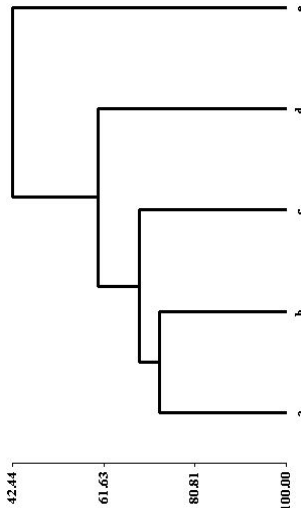
Fig. 3. UPGMA for 5 different cultivars of Catharanthus roseus (L.) G. Don. based on SI of three isozymes Polymorphism is essential in to use of isozymes as ge- netic marker. When considered the EST, PO and PPO isozymes polymorphism and their coding capacity of the molecules with different velocity, they are convenient for identification of genotypical differences. The topology of the plant based on the isozyme data in addition to such large number of polymorphic zones reflect the validity of the isozyme data to study the genetic diversity and taxo- nomic relationships at intraspecific levels in Madagascar periwinkle ( Catharanthus roseus (L.) G. Don.). Such dis- criminations at the intraspecific levels by isozyme